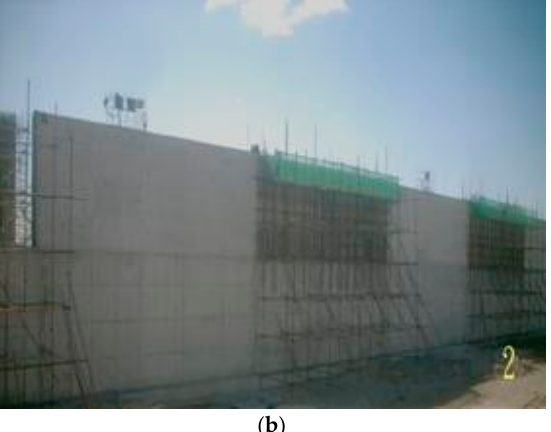
Figure 3. Step-by-step construction of rigid cut-off walls. ( a ) Construction of the lower wall. ( b ) Construction of the upper wall.